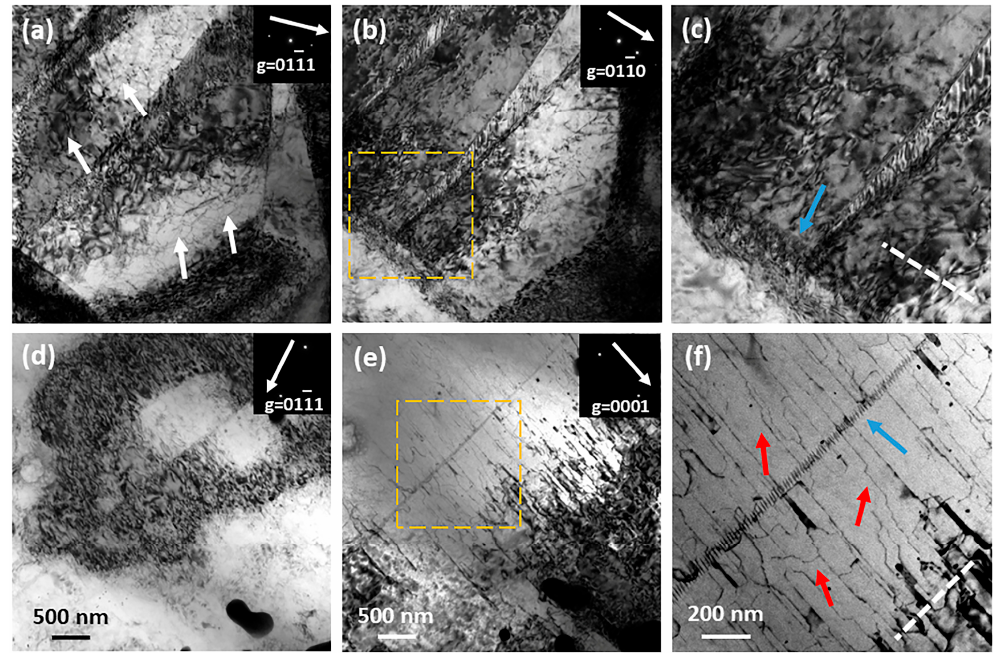
Figure 11. BF TEM images under two-beam condition of as-extruded Alloy1 ( a – c ) and Alloy4 ( d – f ). The observed samples are subjected to 12% tensile deformation, and the inserts represent diffraction vector in each sample, white dot lines represent basal plane trace.